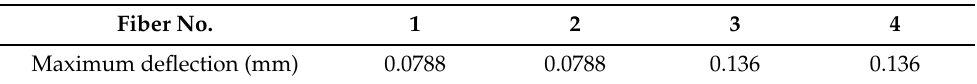
Figure 6. Distribution of von Mises strain for load case ( d = 8, φ = 90) in: ( a ) Fiber-2 and Indenter-2, and ( b ) the flexible shell. Table 3. Maximum deflection of optical fibers when force is applied exactly on top of their corre- sponding